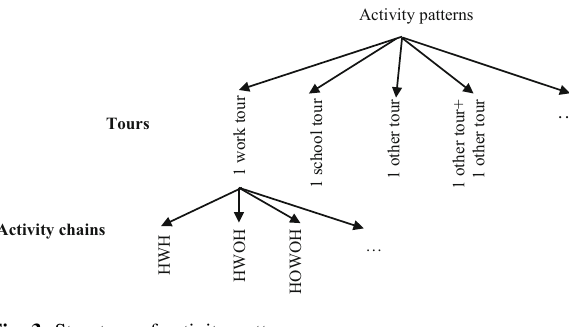
Fig. 3 Structure of activity